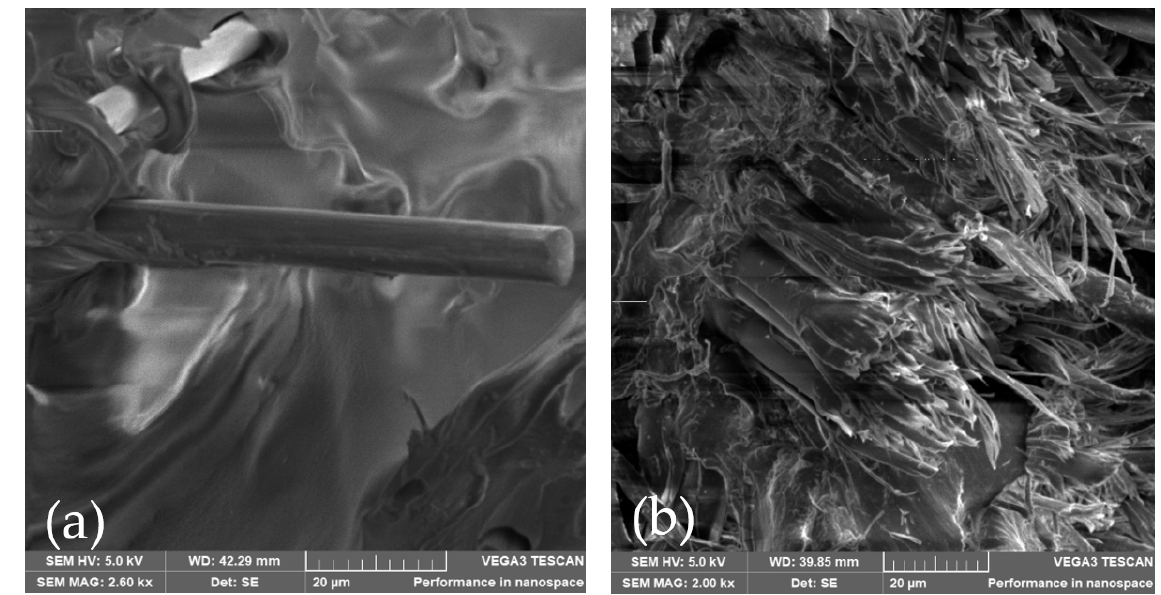
Figure 15. ( a ) close up of fiber pull out in axial static test, ( b ) fiber tearing in alternative bending